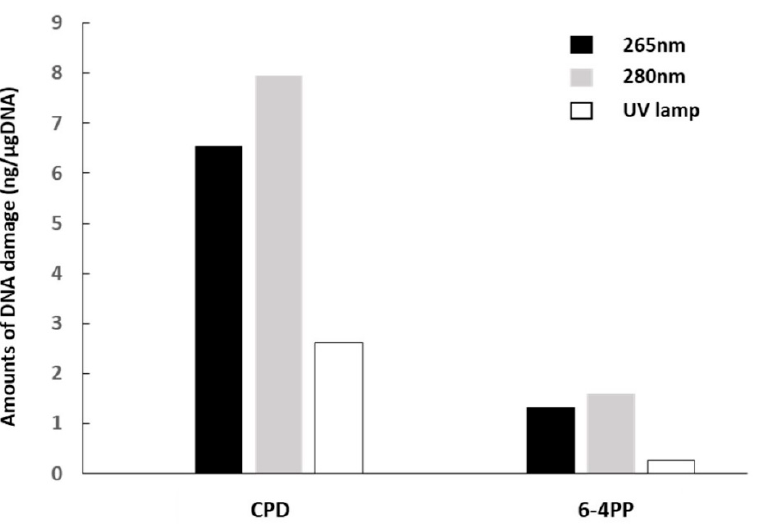
Figure 6. Detection of DUV-LED light-induced DNA damage by quantification of CPD and 6–4PP with ELISA. DNA samples extracted from F. nucleatum after 30 s irradiation with 265 nm LED light (black bars) or 280 nm LED light (grey bars) were measured for amounts of CPD and 6–4PP per microgram of DNA. E. coli irradiated with a UV lamp (hatched bar) were used as a positive control.